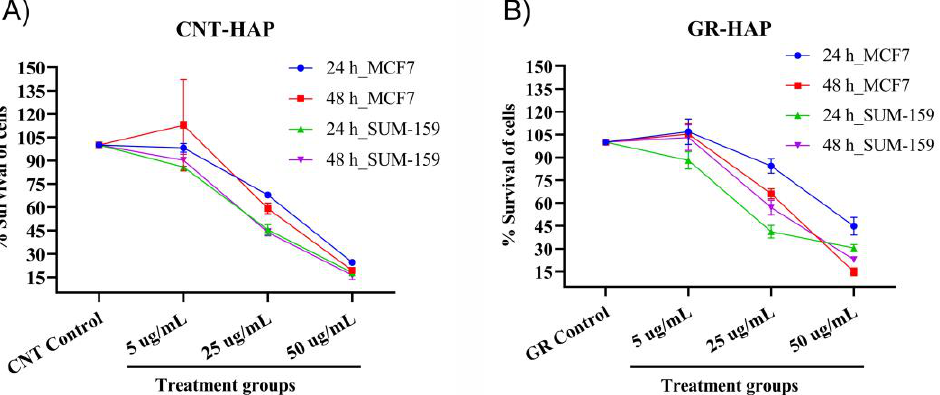
Figure 4. CNT-HAP and GR-HAP suppressed cell survival in a dose and time-dependent manner. ( A ) Cytotoxicity of CNTs-HAP at different concentrations and incubation periods over MCF-7 and SUM-159 cell lines. ( B ) Cytotoxicity of GR-HAP at different concentrations and incubation periods over MCF-7 and SUM-159 cell lines.